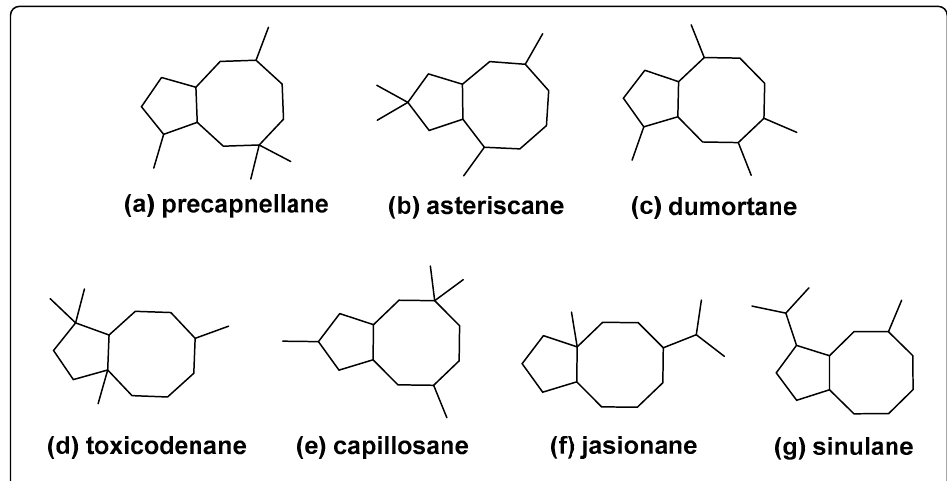
Figure 1. Carbon skeletons of bicyclo [6.3.0] sesquiterpenoids ( a – g ).